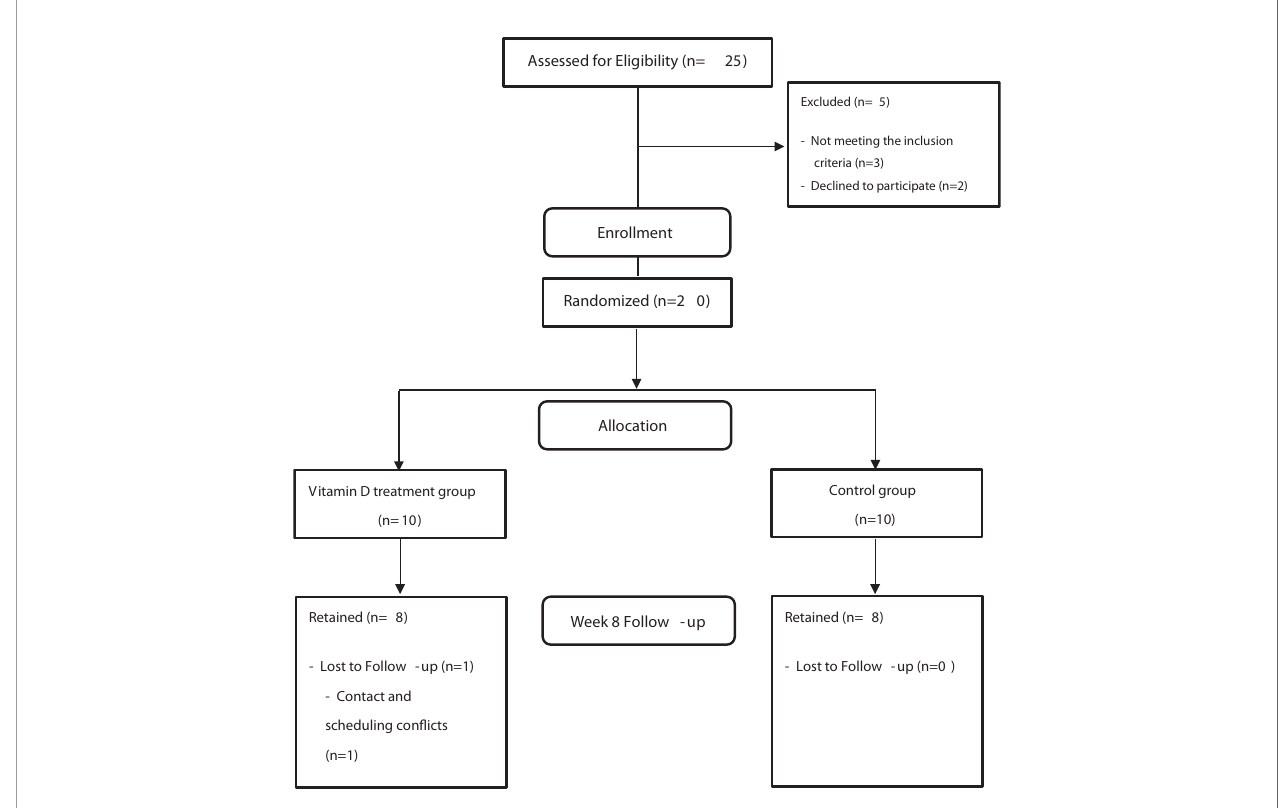
FIGURE 1 | Schematic diagram showing the recruitment